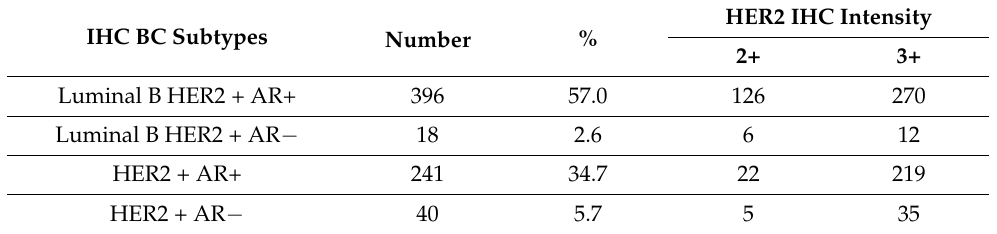
Table 1. HER2-positive BC subtypes proportion and immunohistochemistry positivity frequency.